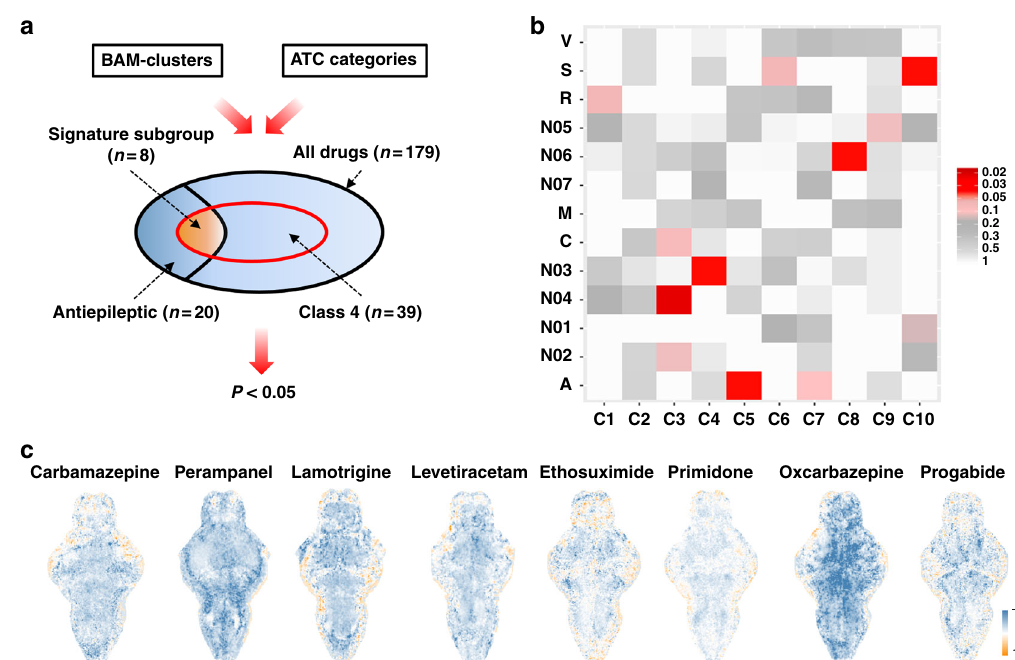
Fig. 3 Association of BAM clusters with functional drug categories. a Schematic of the hypergeometric test for overrepresentation of a speci fi c Anatomical Therapeutic Chemical (ATC) category by a phenotypic BAM cluster. b A heat map illustrating statistical associations between ATC categories and identi fi ed BAM cluster. Color coding is based on p values derived from the hypergeometric tests (red: lower p values or more signi fi cant association; gray: higher p values or less signi fi cant association). c The T-score BAMs of the drugs in the signature subgroup of cluster 4, which is signi fi cantly associated with N03:Antiepileptics ATC